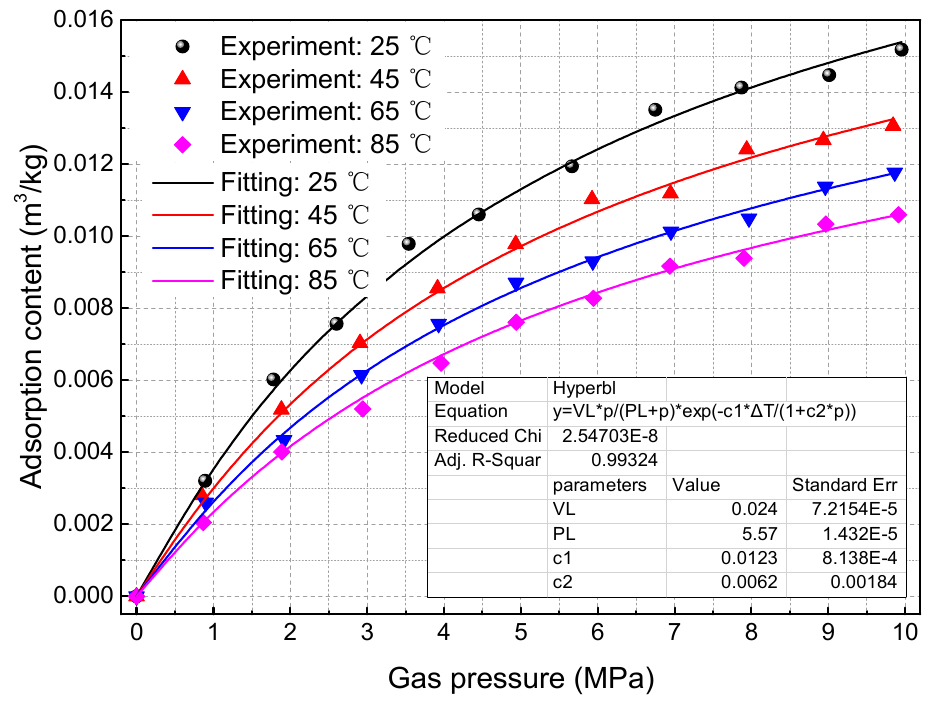
Figure 2. Validation of temperature modified Langmuir equation.